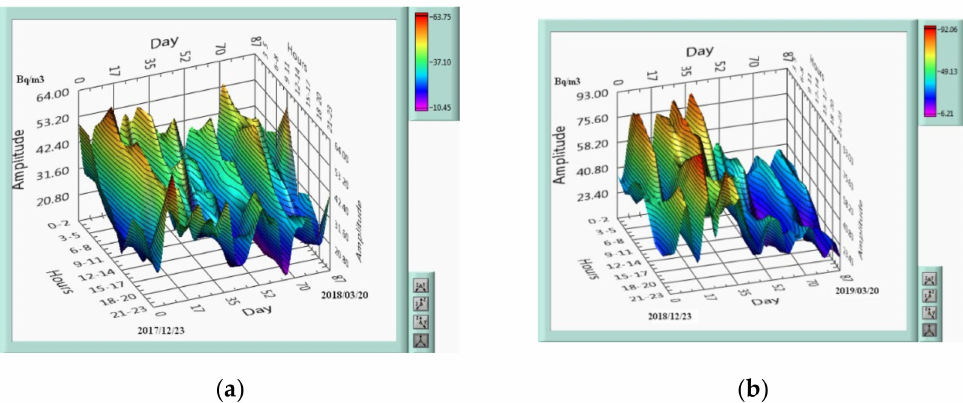
Figure 7. Radon evolution in Bisoca station, winter: ( a ) 2017; ( b ) 2018.